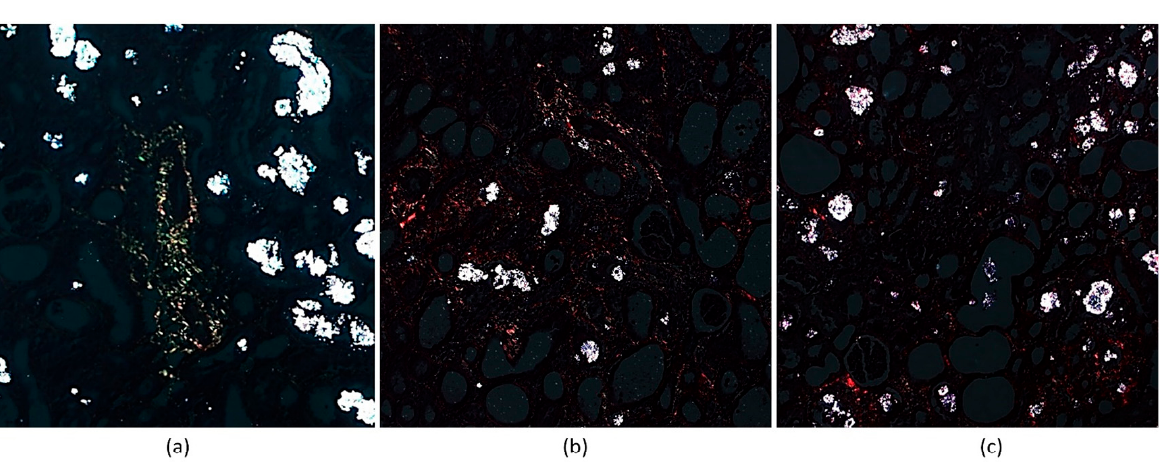
Figure 7. Picrosirius red stained (PRS) image of renal tissue. ( a ) MSC-EV, ( b ) eEPC-EV and ( c ) Control. It was possible to observe collagen fibers, stained red and green, in all groups analyzed. Microscope objective: 20×.